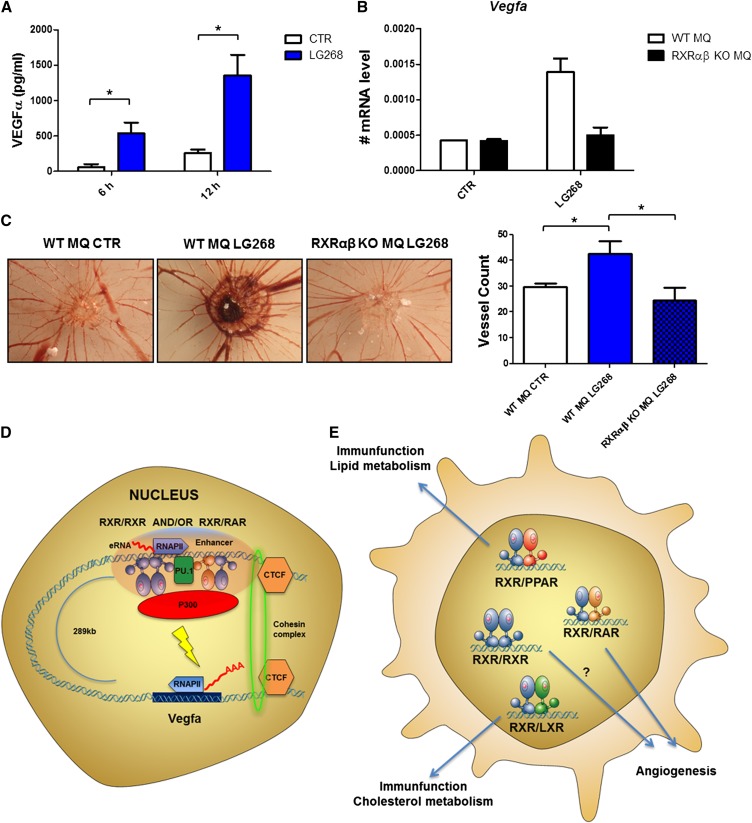
RXR activation leads to increased angiogenic activity in macrophages. (A) VEGFα protein levels determined from supernatants of macrophages treated with LG268 for the indicated periods of time determined by ELISA. The mean and ±SD of triplicate determinations are shown. Asterisk represents significant difference at P < 0.05; n = 3. (B) Vegfa mRNA levels determined using RT-qPCR in wild-type (WT) and RXRα/β knockout (KO) macrophages. The mean and ±SD of duplicate determinations are shown. (C) Macrophage angiogenesis activity was determined using CAM assay in the presence or absence of LG268 using wild-type and RXRα/β knockout macrophages. Representative images (left) and bar chart of quantification (right) are shown. The mean and ±SD of three biological replicates are shown. Asterisk represents significant difference at P < 0.05; n = 3. (D) The molecular mechanism through which Vegfa is regulated in macrophages. Vegfa harbors a set of very-long-range enhancers. The enhancers are marked by the lineage-determining transcription factor PU.1 and are able to recruit RXR presumably as a heterodimer with RAR or in a homodimeric form. Upon ligand stimulation, P300 is recruited, and eRNA production is highly increased. These elements can get into the close proximity of the gene promoter by looping, which is enhanced in the presence of the RXR activator (LG268) and leads to increased gene expression. This regulatory unit is bordered by CTCF/cohesin (RAD21) cobinding, which is thought to contribute to the topological domain structure of mammalian genomes and stabilizes chromatin loops. (E) Schematic representation of the various nuclear receptor dimers and their biological significance in macrophages. PPAR/RXR are known to inhibit the inflammatory response upon activation by either side as a permissive heterodimer, while the LXR/RXR heterodimer regulates inflammatory response, cholesterol metabolism, and triglyceride biosynthesis. Our results shed light on the effect of putative, permissive, RAR/RXR, or possibly RXR/RXR dimers in the angiogenesis program of macrophages, most probably through the regulation of Vegfa and/or Hbegf.